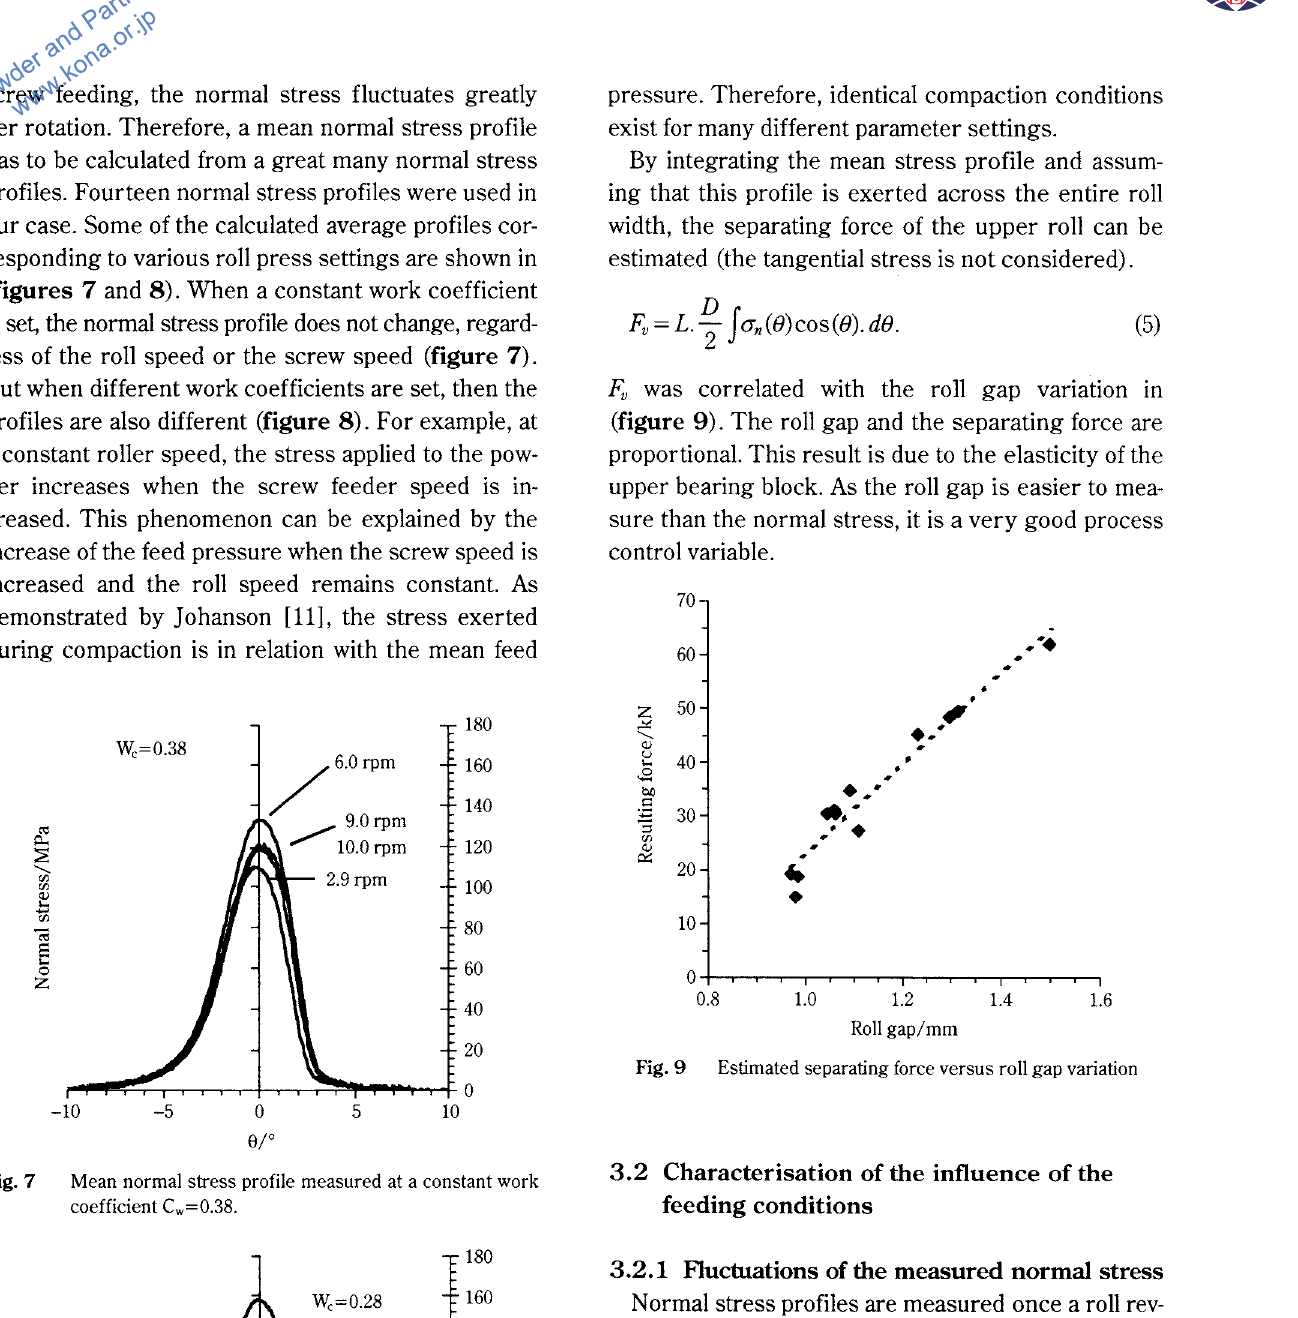
Mean normal stress profile measured at a constant work coefficient Cw=0.38.